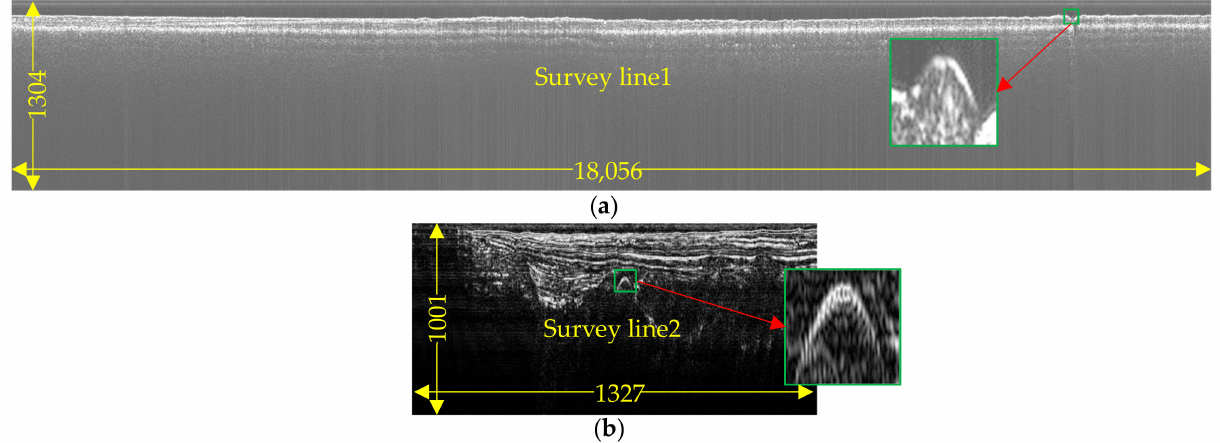
Figure 25. Complete survey lines for real-time pipeline detection experiment. ( a ) SBP data collected by EdgeTech 3100P in Zhujiang Estuary; ( b ) SBP data collected by Chirp III in Yangtze Estuary.